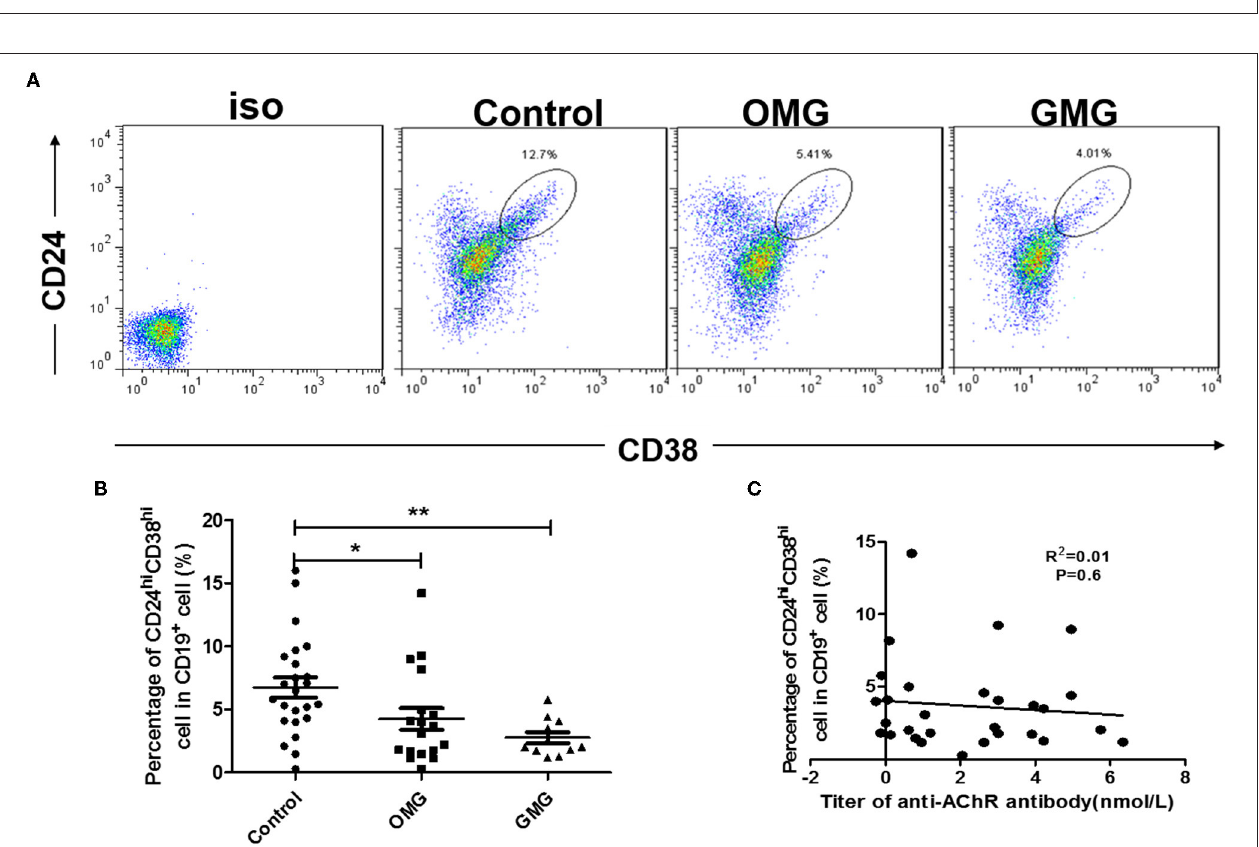
FIGURE 1 | gating for patients with OMG, GMG, and healthy controls. (F) The frequency of CD19 + IL-10 + cell in different MG types according to age at onset. (G) The frequency of CD19 + IL-10 + cells in different thymus status. (H) The frequency of CD19 + IL-10 + cells in different gender. (I) The titer of anti-AChR antibody in MG patients, including 21 healthy controls, 23 OMG patients, and 18 GMG patients. (J) The proportion of CD19 + IL-10 + cells had no correlation with the level of anti-AChR antibody, and the samples were from 41 patients with MG. p -values were calculated by Student’s t -test; * p < 0.05, ** p < 0.01, *** p < 0.001, ns, not significant.